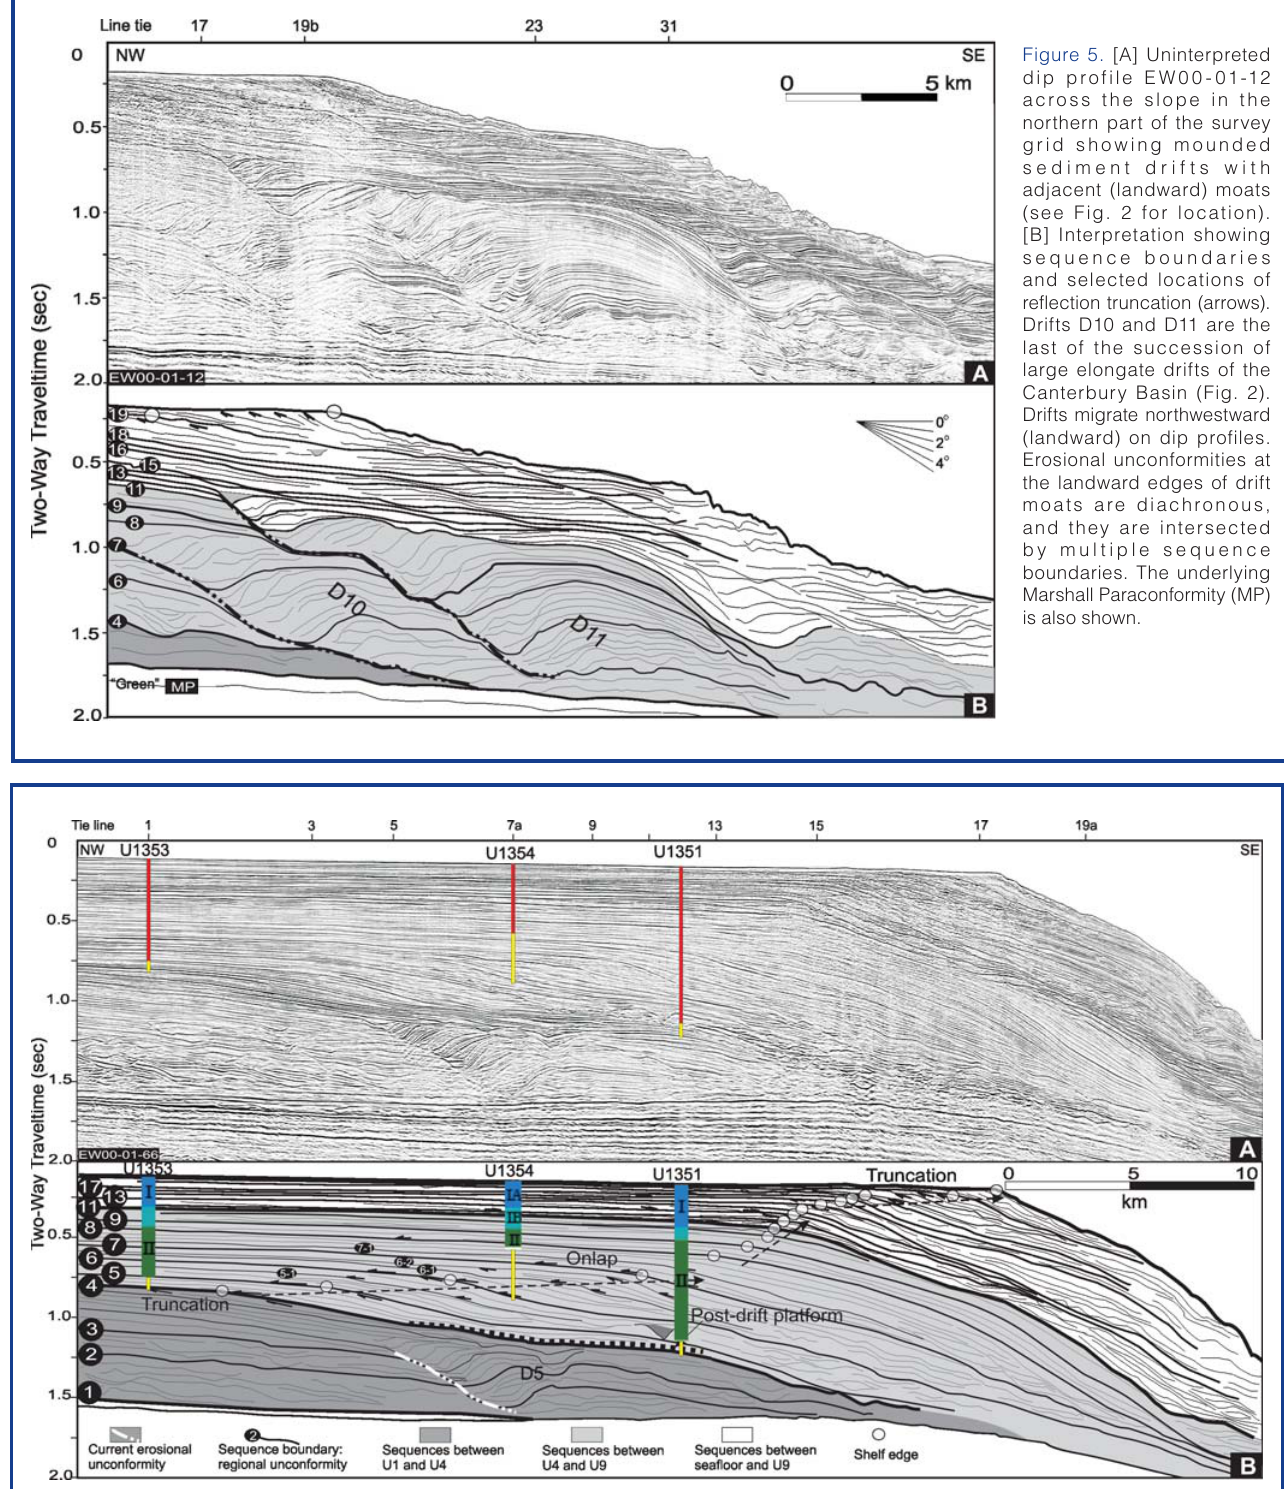
Figure 6. [A] Uninterpreted MCS dip profile EW00-01-66 from the southern part of the survey grid showing locations of sites U1351, U1353, and U1354. Actual penetrations shown in red, proposed penetrations in yellow (see Fig. 2 for location). [B] Interpretation showing sequence boundaries and selected locations of onlap, truncation, and downlap (arrows). Lithostratigraphic units defined at shelf Sites U1353, U1354, and U1351 are also shown. Clinoform rollovers, or breaks, representing paleoshelf edges, are marked by circles. Paleoshelf edges from U4 to U8 prograde steadily. The amount of progradation decreases from U8 to U12, increasing again from U13 to U19. U4–U10 are onlapped and truncate underlying reflections; internal reflection geometries from U4 to U10 are mainly sigmoidal. In contrast, U11–U19 are downlapped on paleoshelves, but also truncate underlying reflections, and internal reflection geometries from U11 to seafloor are oblique. Site U1351 sampled paleoslopes of U6–U7 and sampled U8–U19 landward of their paleoshelf edges. Sites U1353 and U1354 sampled sequence boundaries from U5 to U18 landward of their paleoshelf edges in more proximal settings. Sediment drift development in this area had largely ceased by U4; only drift D5 is present. Prograding clinoforms dominate later sequences.